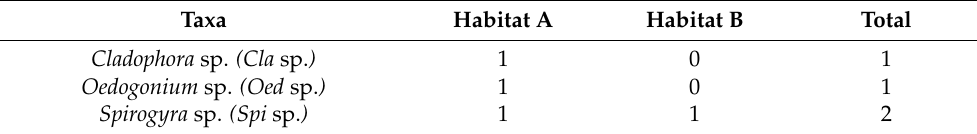
Table 1. Occurrence of plant species at habitats—number of sites (abbreviations used in figures). Taxa Habitat A Habitat B Total Cladophora sp. (Cla sp. ) 1 0 1 Oedogonium sp. (Oed sp. ) 1 0 1 Spirogyra sp. (Spi sp. )